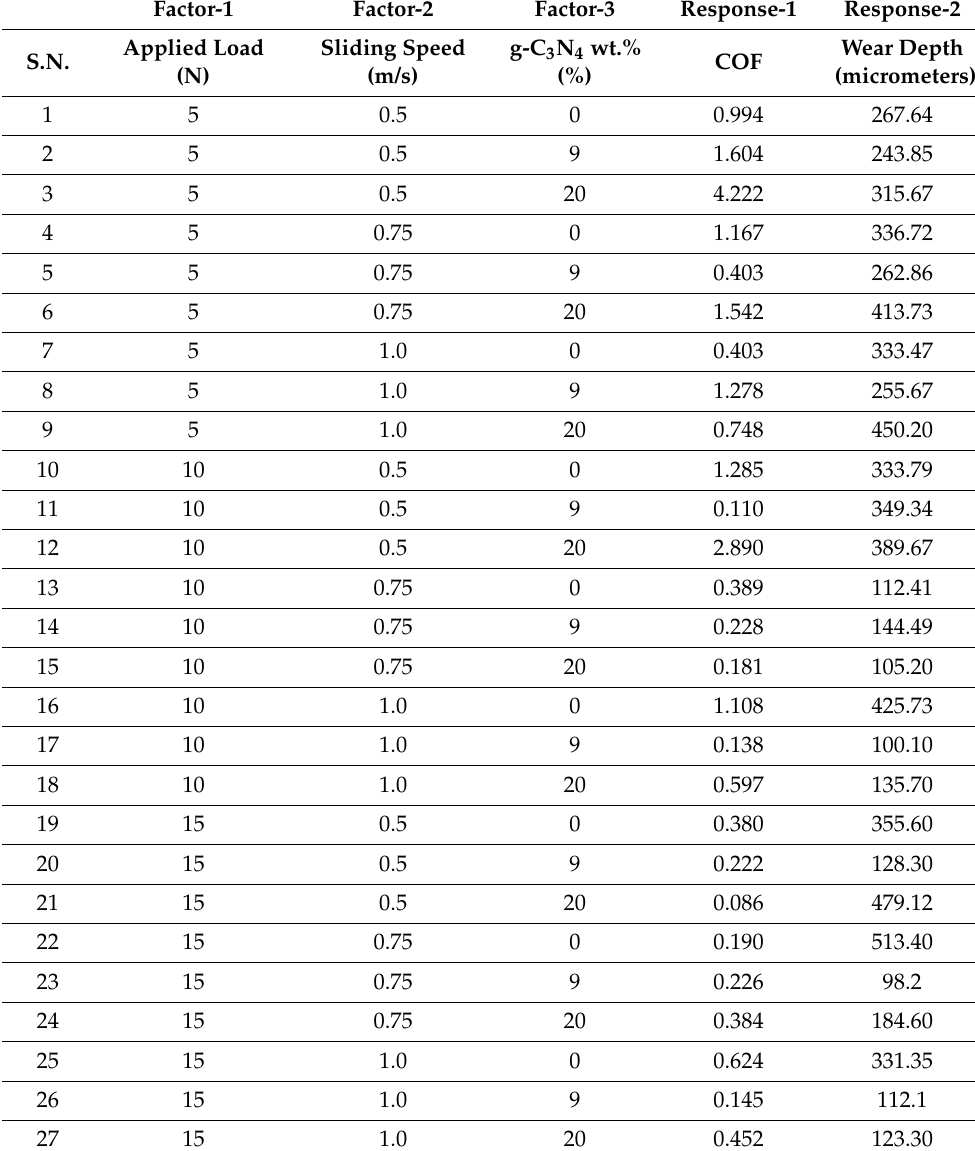
Table 4. Design of experiment (DOE) with experimental